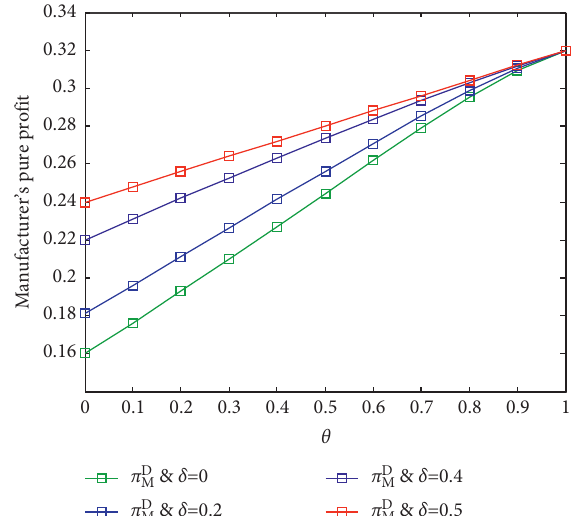
Figure 2: The joint impacts of δ and θ on the manufacturer’s pure